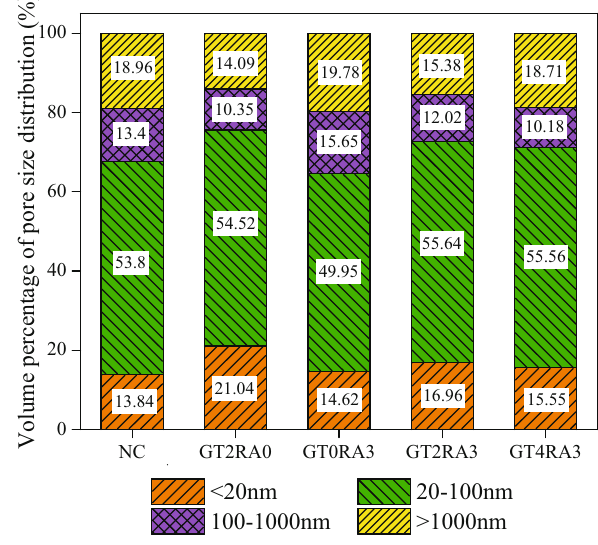
Figure 18: Pore volume percentage of GTRAC.